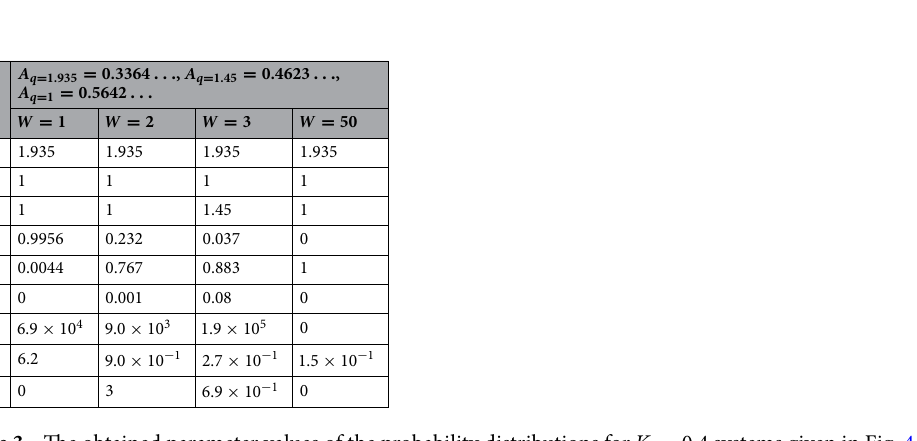
Table 3. The obtained parameter values of the probability distributions for K = 0.4 systems given in Fig. 4.